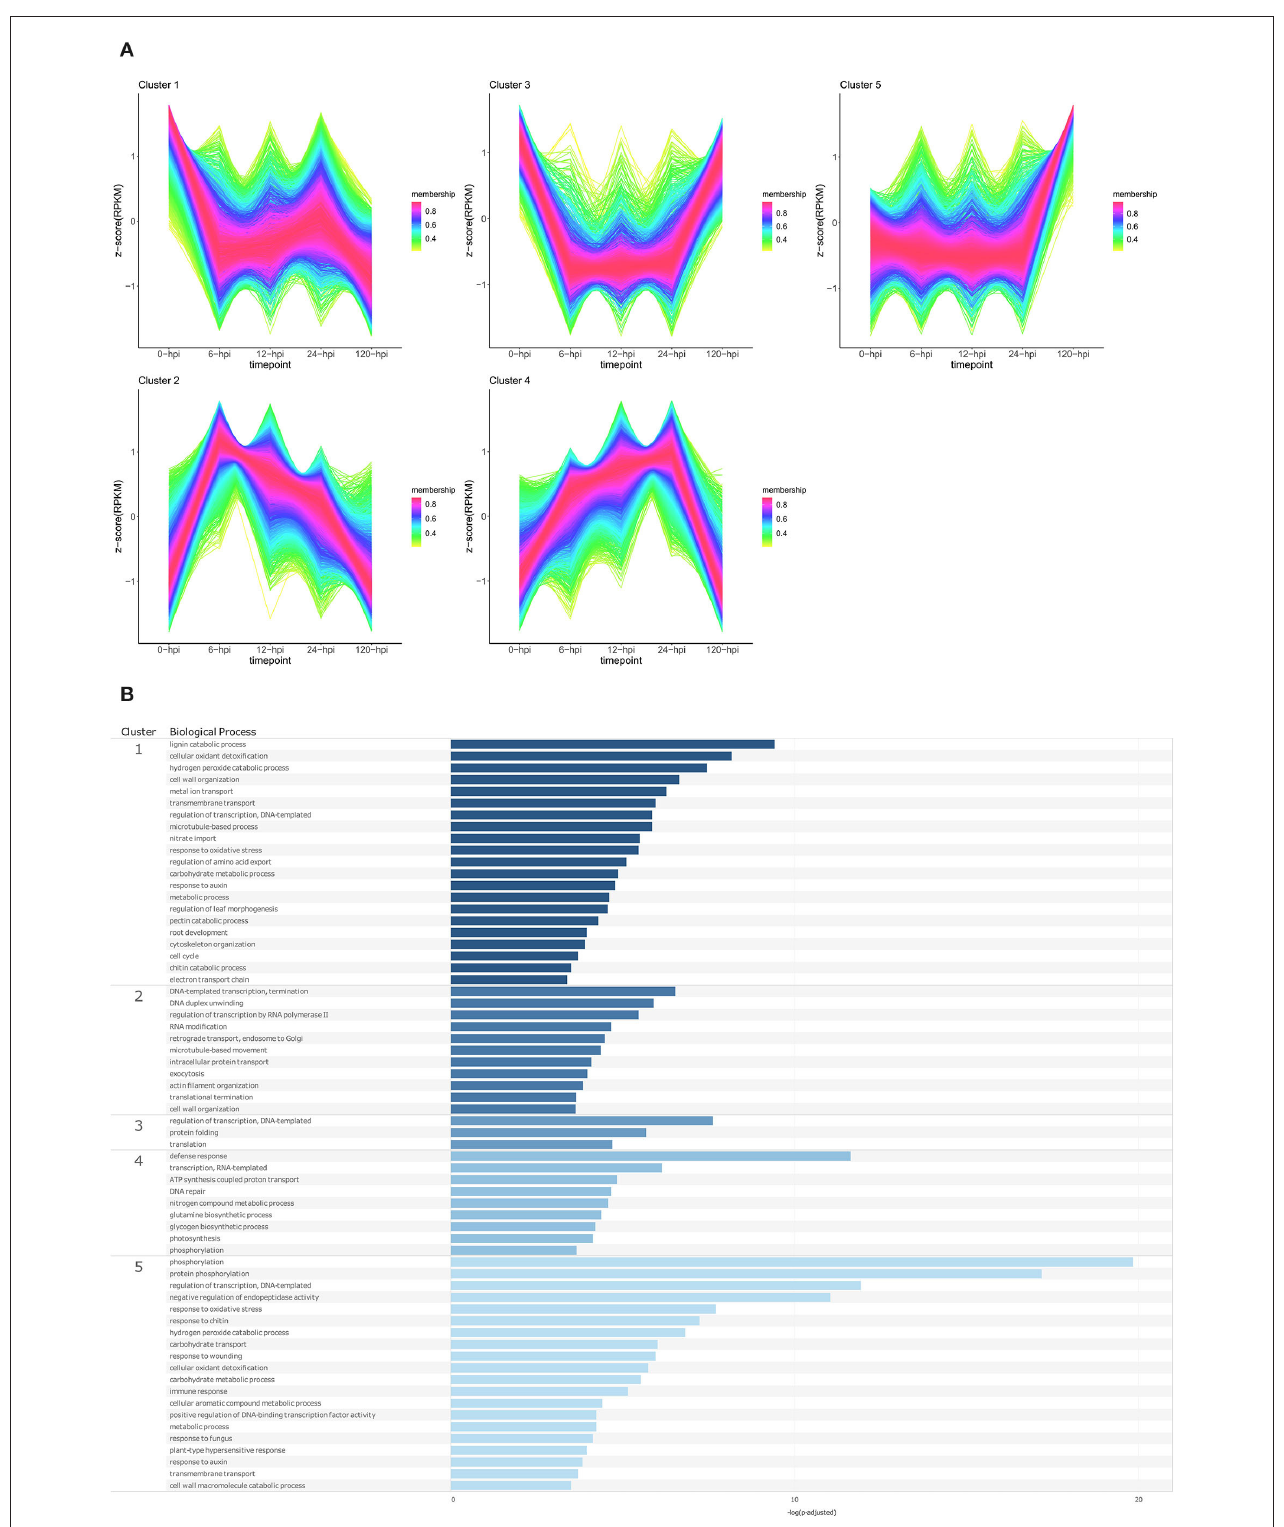
FIGURE 4 | Temporal clustering and Gene Ontology enrichment of Persea americana differentially expressed genes (DEGs) in Dusa ® following inoculation with Phytophthora cinnamomi. (A) Sample libraries from the partially resistant P. americana rootstock Dusa ® following inoculation with P. cinnamomi or mock